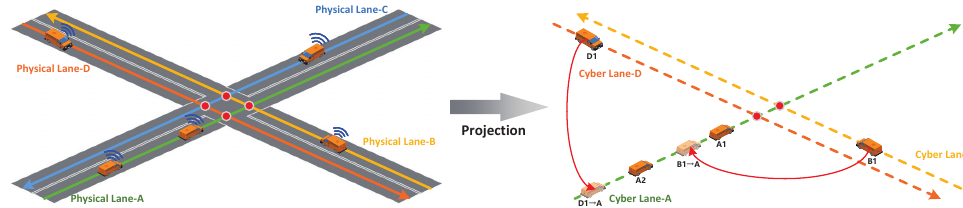
Figure 3. Vehicle projection from a physical lane to a cyber